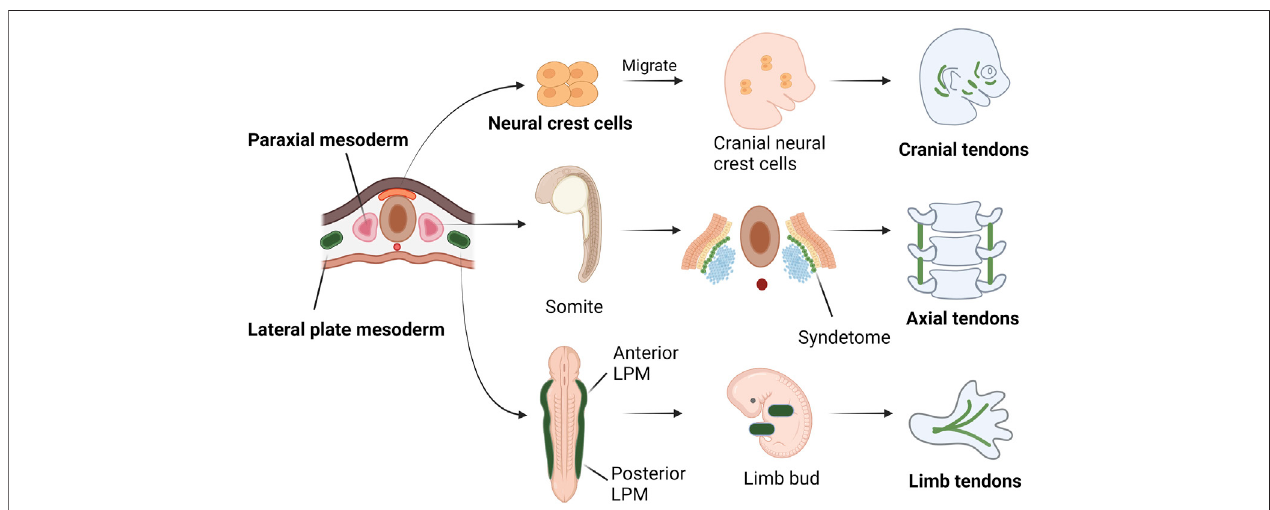
FIGURE 1 | Tendons at different locations have different embryonic origins. Tendons at the cranial region are originated from the neural crest. Some of the nerve crestcellsfromtheectodermmigratetothecranialareaanddifferentiateintotendonprogenitors.Theaxialtendonsarederivedinthesyndetome,adorsolateralstripeof the sclerotome at the junction between adjacent myotomes. At a cross section of embryo, the LPM is formed on either side of the central axis and is subdivided into anterior and posterior parts, corresponding to four limb buds. In limb buds, tendon progenitors are derived from the mesenchyme directly under the ectoderm, in locations that follow the proximal-to-distal outgrowth of the limb